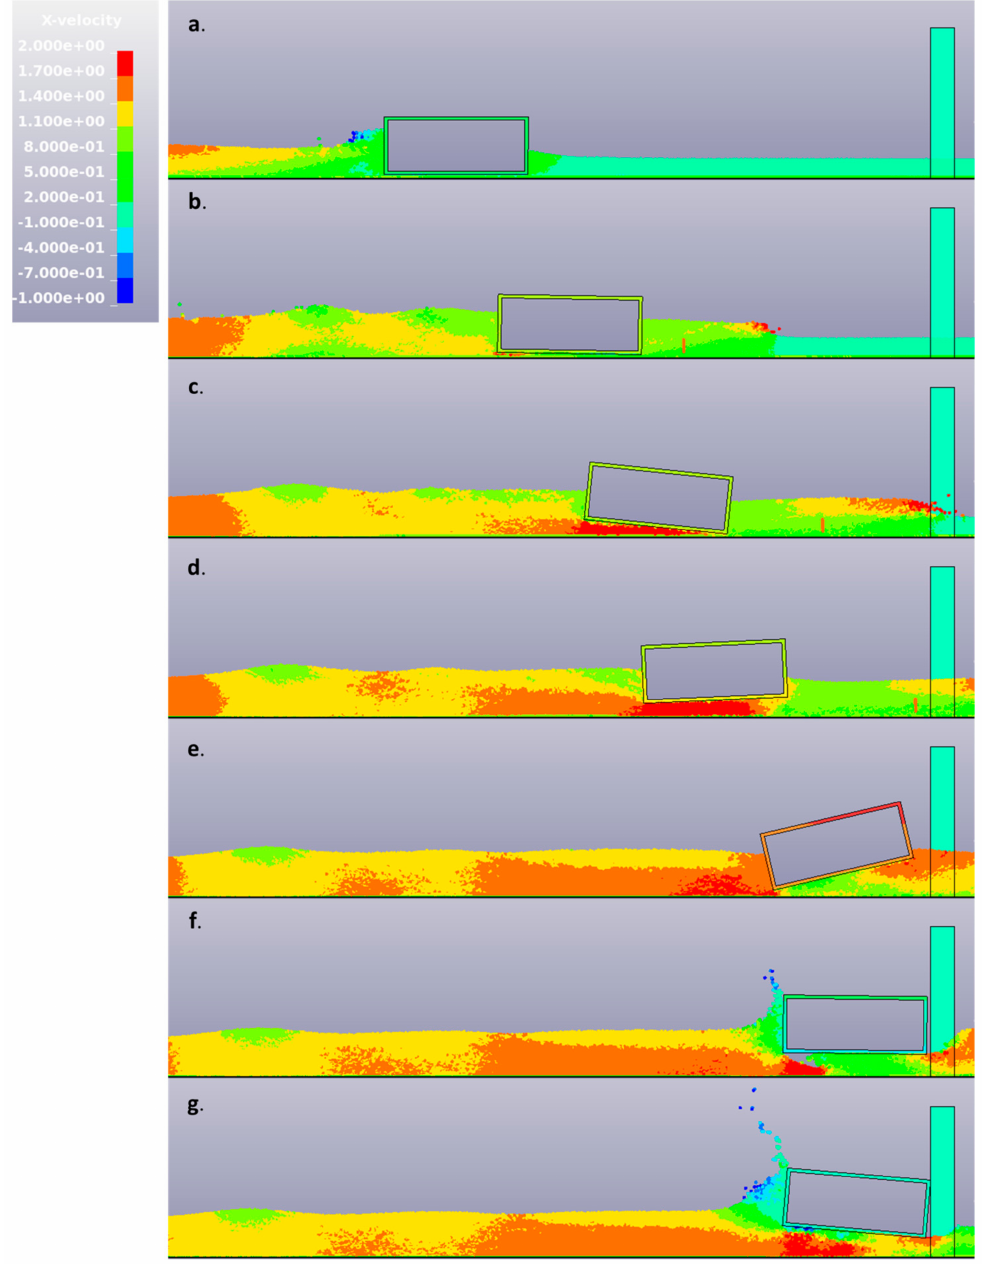
Figure 9. Selected instants of the debris − wave interaction and impact on the column of the free debris. Numerical results for the hydrodynamic case with h 1 = 2.496 m, h 2 = 0.13 m and T erf = 30